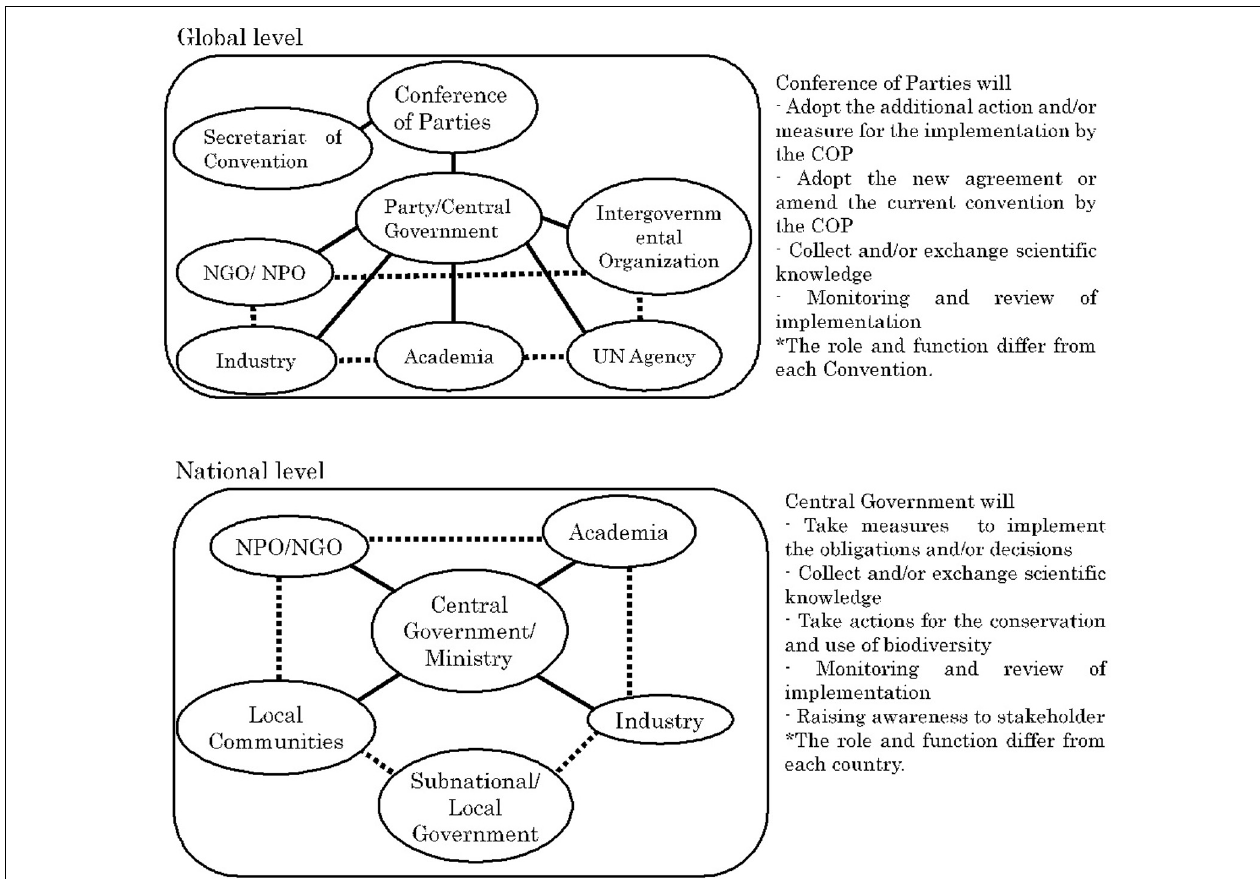
FIGURE 1 | Interaction of scientific knowledge among various sector at the Global and National Levels.